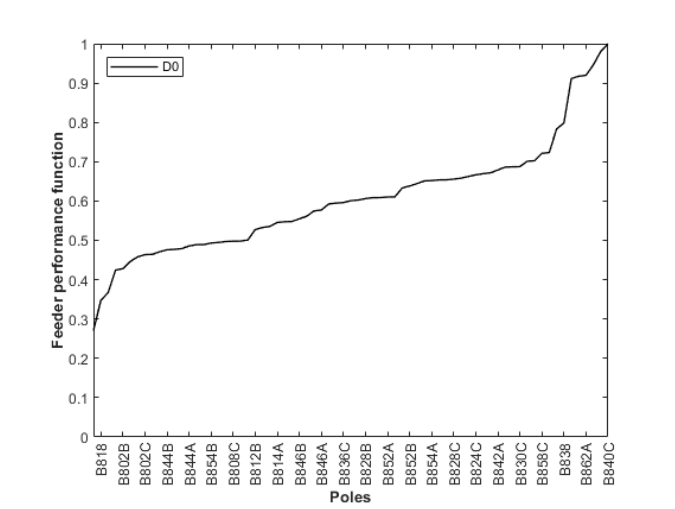
Figure 17. D function for the base case with m = 1 and n = 0.